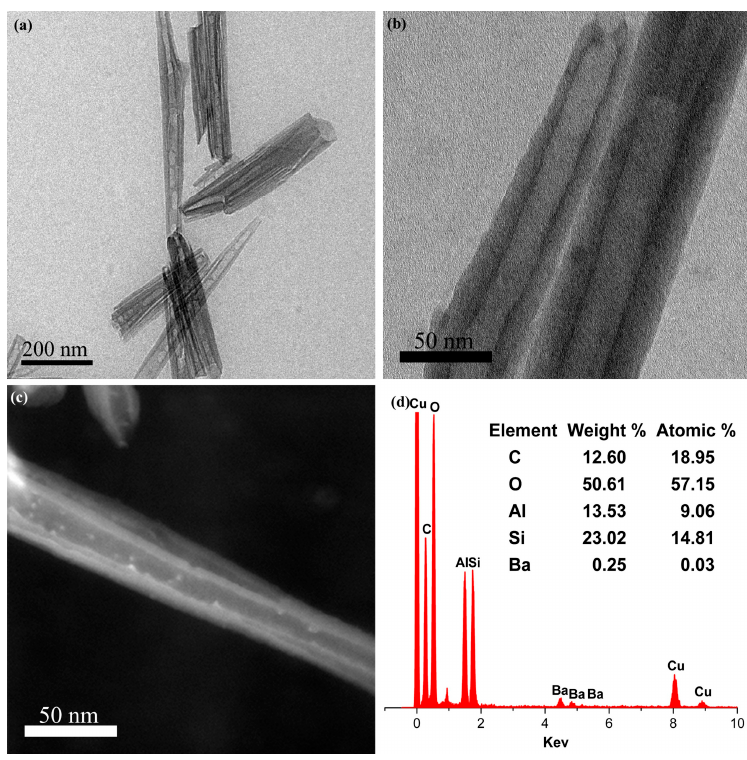
Figure 6. Morphologies of the samples. TEM images of ( a ) Hal, ( b ) A-Hal, ( c ) BaCO 3 /A-Hal-T and ( d ) EDX spectrum of BaCO 3 /A-Hal-T.